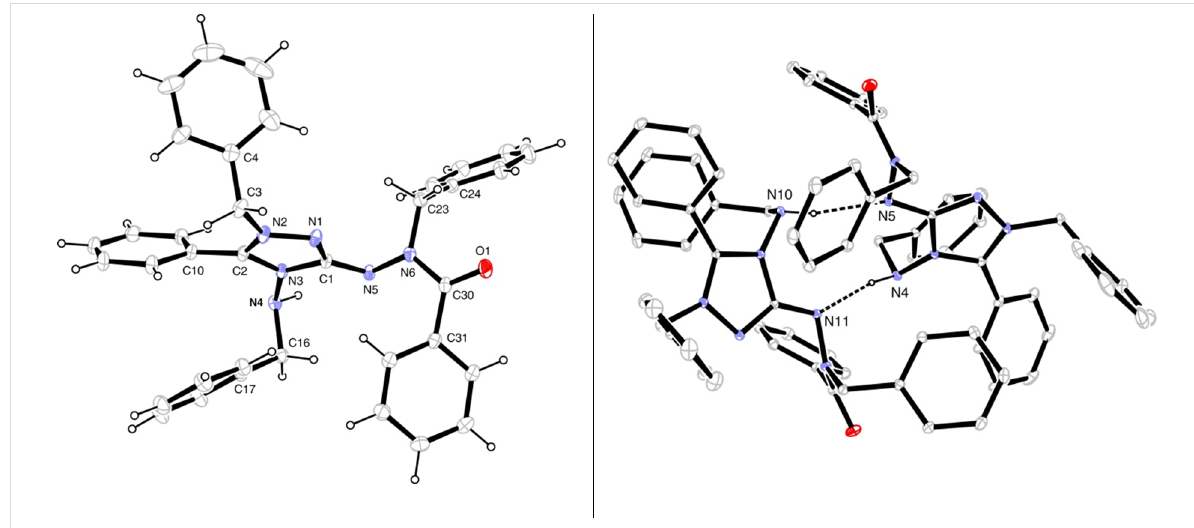
Figure 4: Solid-state structure of mesoionic compound 7a (ORTEP plot); thermal displacement ellipsoids are drawn at the 30% probability level. Selected bond lengths (Å): C1–N1 1.343(1), C1–N3 1.398(1), C1–N5 1.322(1), N1–N2 1.389(1), C2–N2 1.317(1), C2–N3 1.357(1); selected torsion